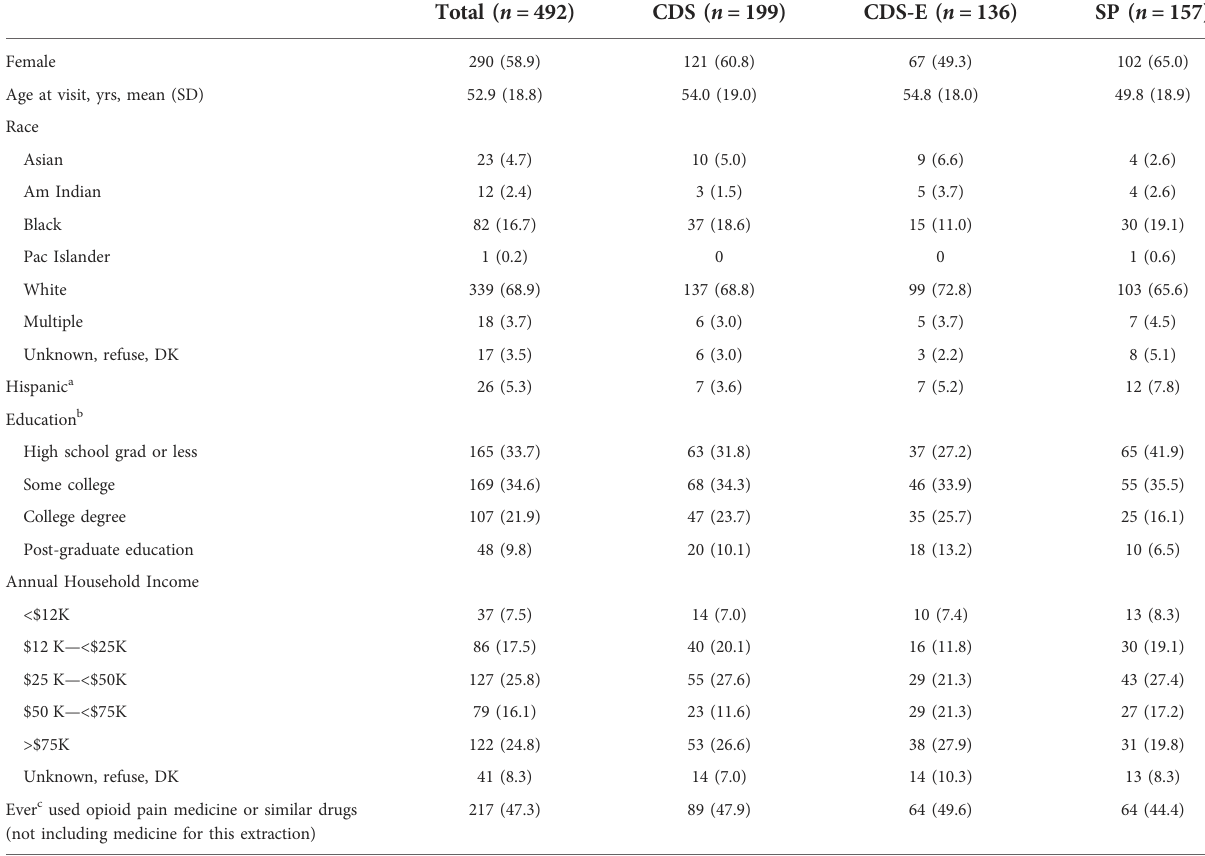
TABLE 1 Participant characteristics ( n =492).